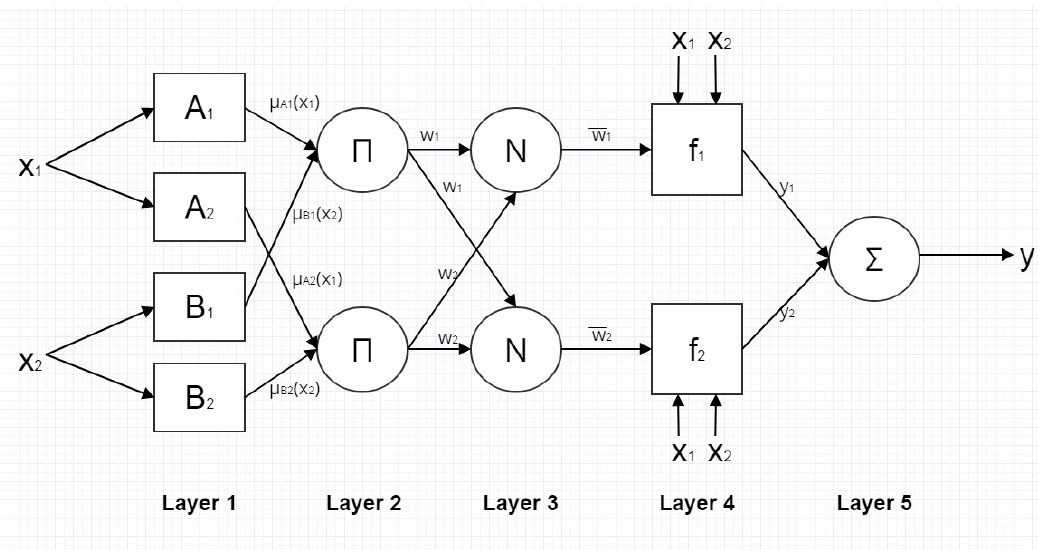
Figure 7. Structure of ANFIS.